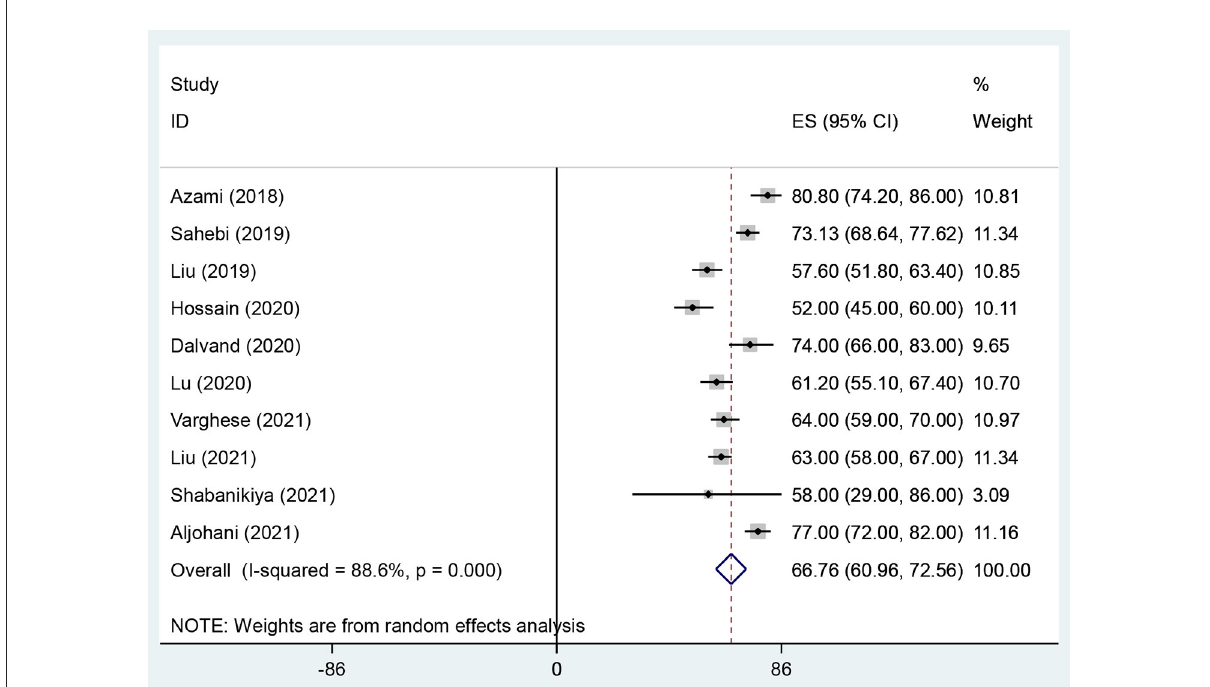
FIGURE4 The Forest plot of overall and individual prevalence of verbal violence with 95% confidence interval.